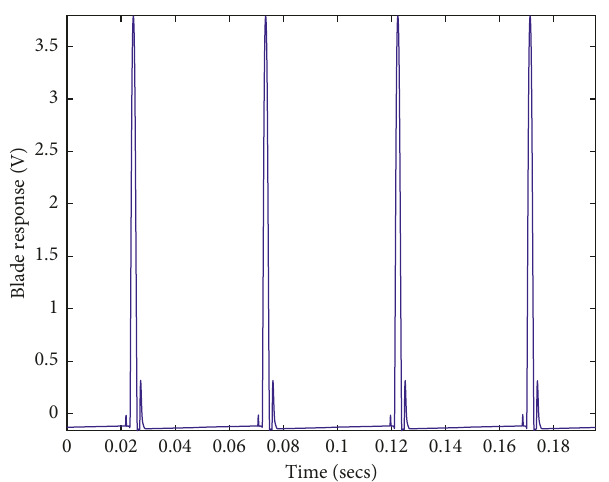
Figure 10: Reconstructed blade 1 BTT signal up to four completed